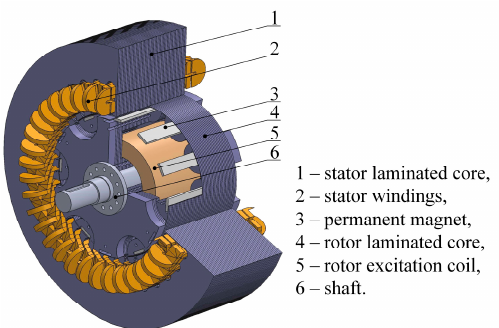
Figure 3. Design of the claw pole machine.